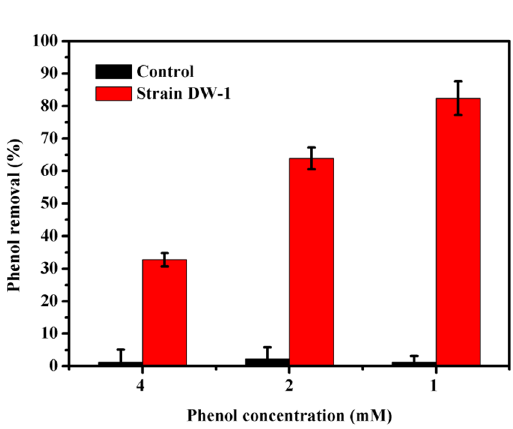
Figure 2. TEM image of Acinetobacter sp. DW-1 grown in MSM supplemented with 4 mM phenol as single carbon and energy source. The arrows indicate anchor-like appendages among cells.